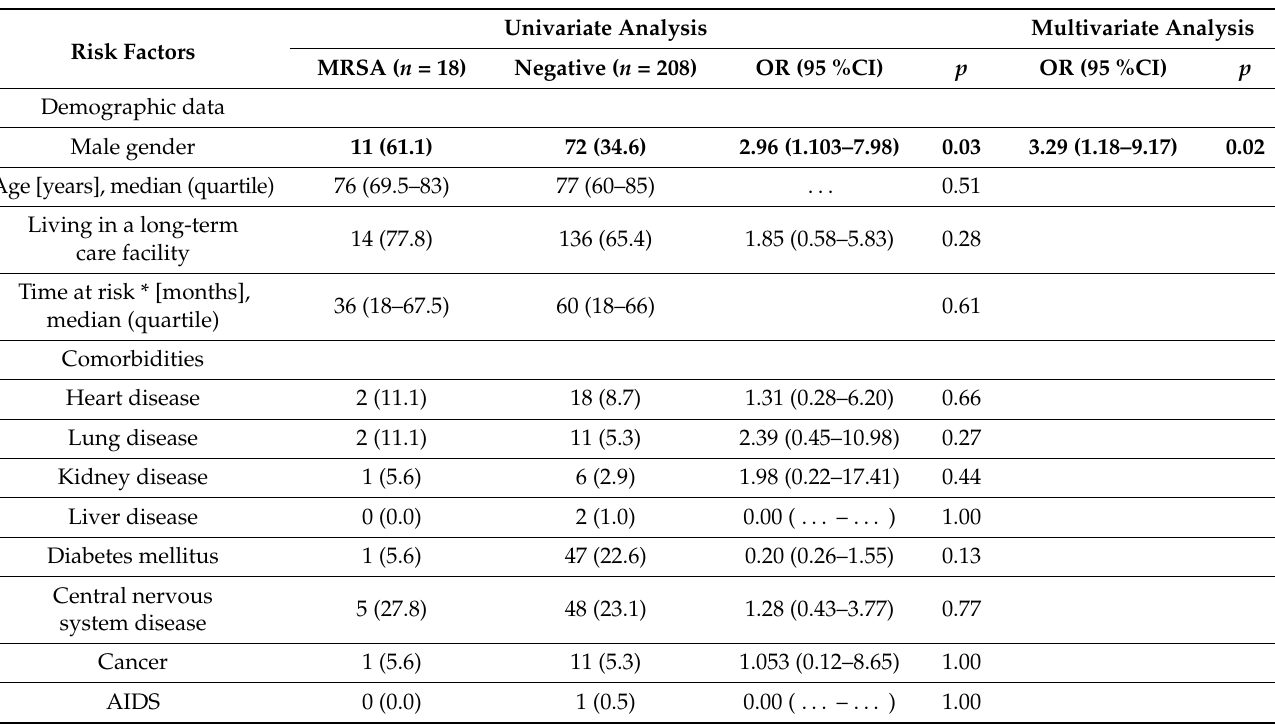
Table 4. Univariate and multivariate analysis (logistic regression model) of predictors of MRSA